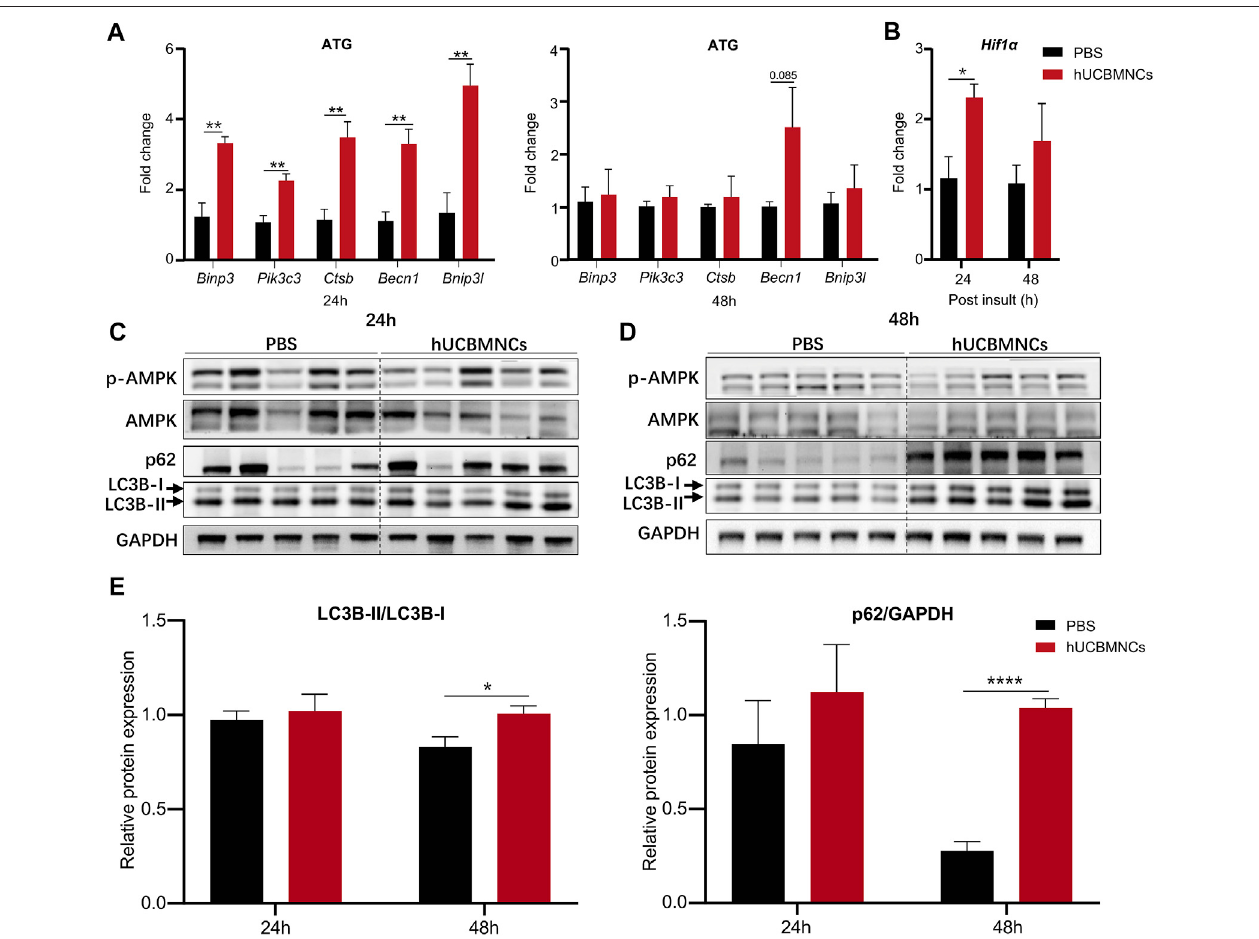
FIGURE 5 | hUCBMNCs treatment enhanced hepatocellular autophagy at mRNA and protein levels. (A) mRNA levels of autophagy-related genes (ATG) in liver at 24 and 48h post CCl 4 injection ( n = 5/time point, experiments were repeated for 3 times). (B) Liver mRNA level of hypoxia inducible factor 1 α ( Hif1 α ) ( n = 5/time point, experimentswererepeatedfor3times). (C,D) Westernblottingresultsofproteinsinautophagypathwayintheliver,includingp-AMPK,AMPK,p62,LC3B-IandLC3B-II at24h (C) and48h (D) postCCl 4 injection( n =5/timepoint,experimentswererepeatedfor3times). (E) RelativeproteinexpressionofLC3B-II/LC3B-I,p62/GAPDH at 24 and 48 h post CCl 4 insult ( n = 5/time point, experiments were repeated for 3 times). The bars represent mean ± SEM.